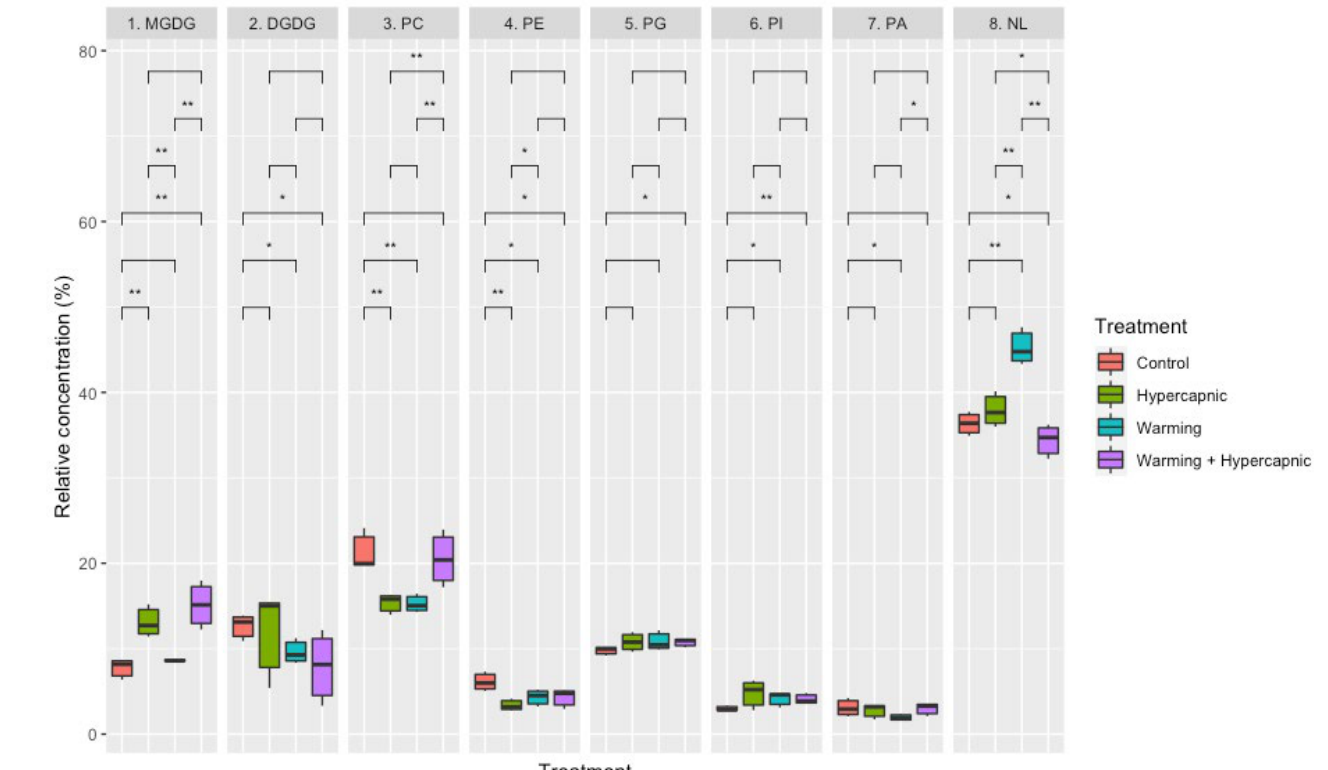
Figure 3. Relative Zostera noltii lipidscape composition (monogalactosyldiacylglycerol, MGDG; digalactosyldiacylglycerol, DGDG; phosphatidylcholine, PC; phosphatidylethanolamine, PE; phosphatidylglycerol, PG; phosphatidylinositol, PI; phosphatidic acid, PA; neutral lipids, NLs) under exposure to control, hypercapnic, warming and combined stress conditions ( n = 3 per treatment; asterisks denote statistical differences among treatments at p < 0.05 (*) and p < 0.01 (**)).